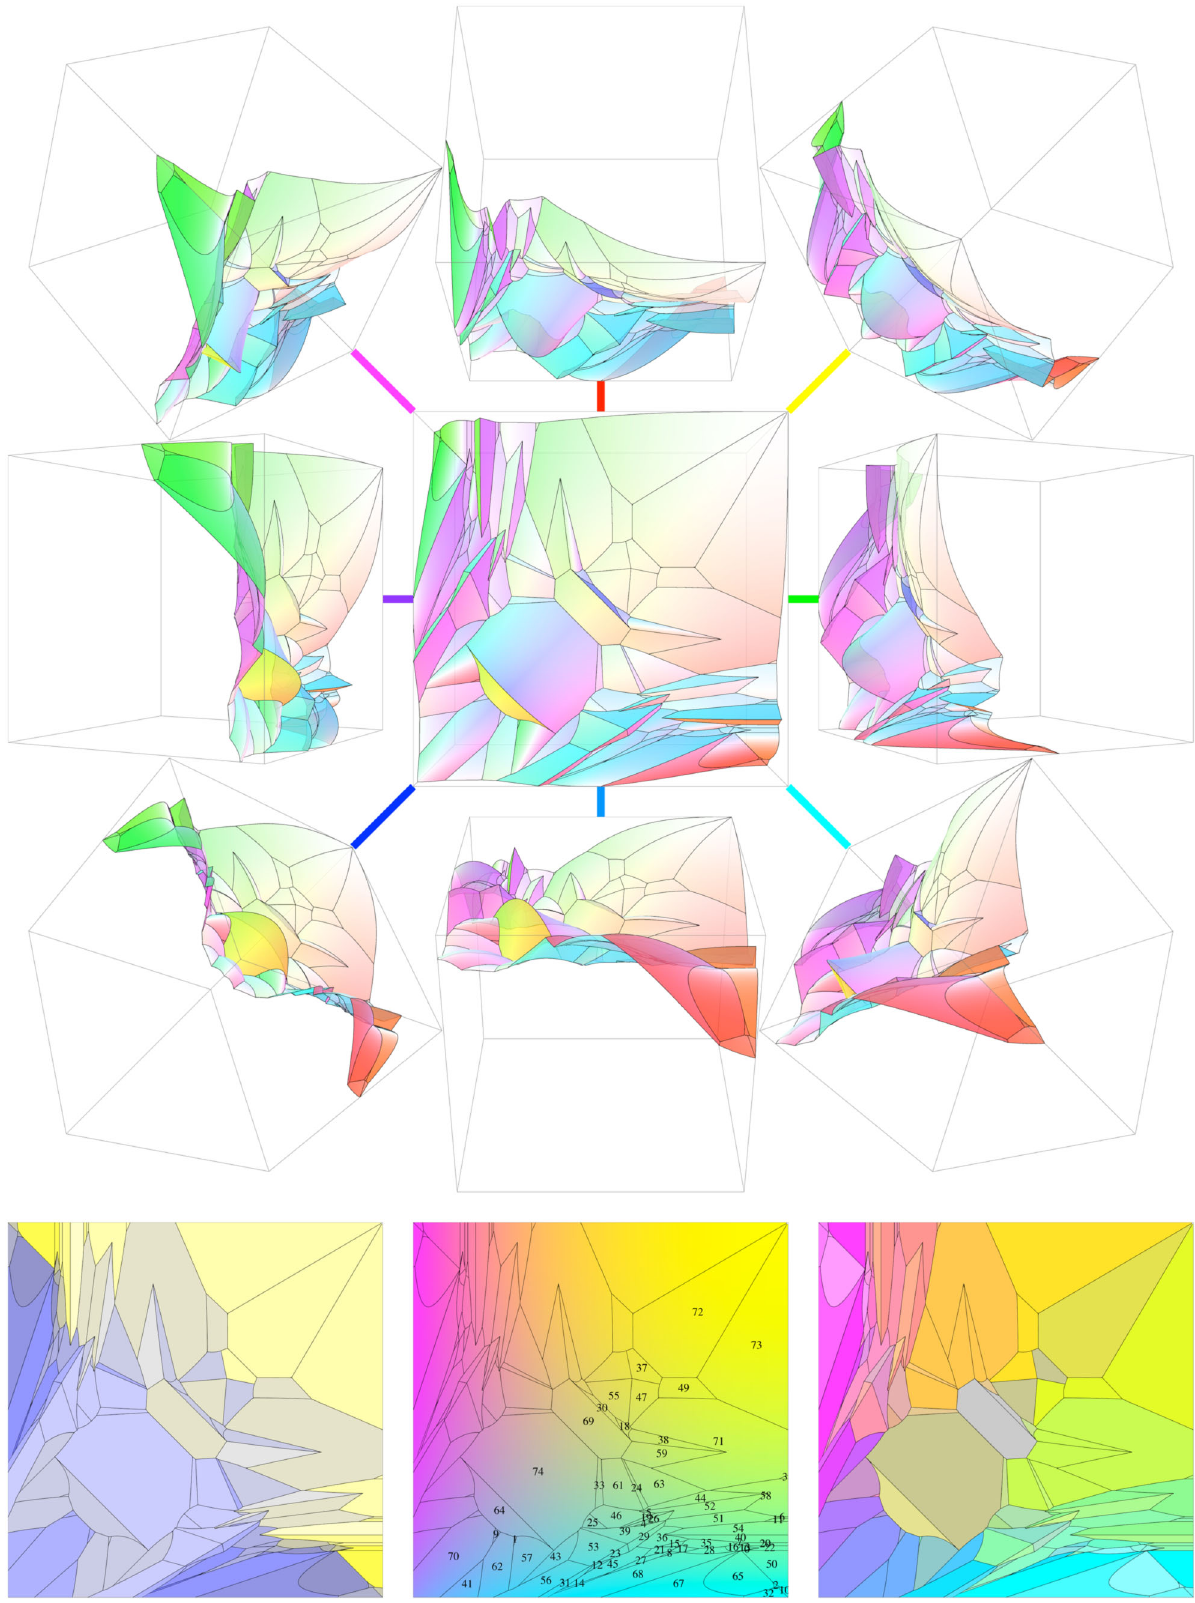
FIG. 9 323 · 2 -family optimal density surface ( 3 × 3 grid of cubes), parallel contacts (bottom left), antiparallel contacts (bottom right), face areas, and region size (bottom